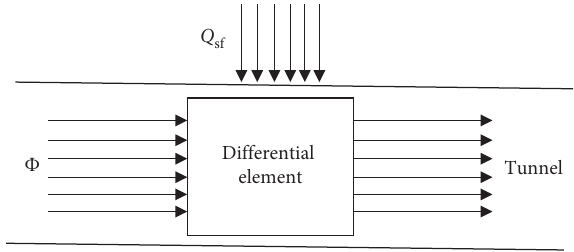
Figure 3: Axial heat transfer model of air in the